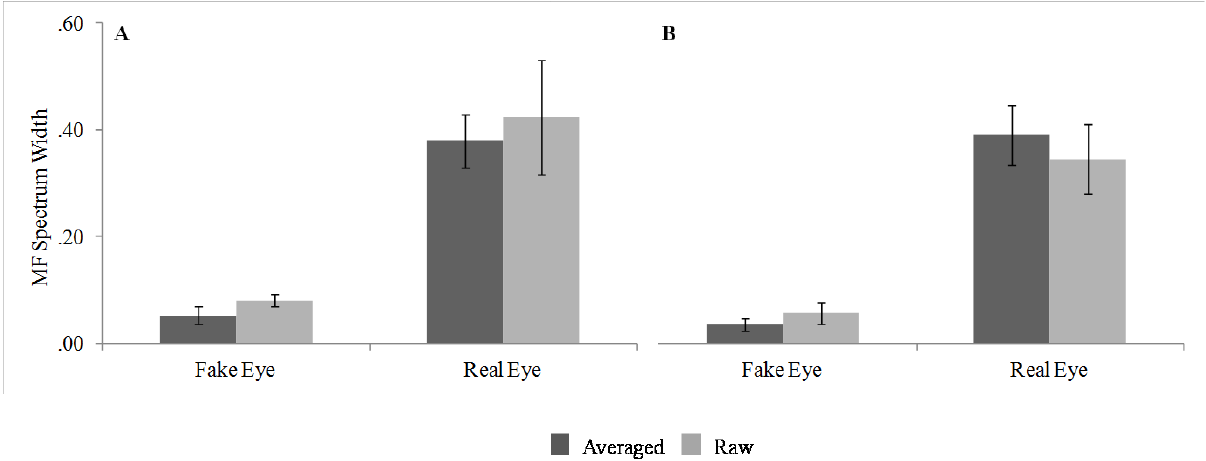
Figure 4. The effects of eye type and data-averaging in MFCWT analyses of (a) raw, untreated time-series and (b) shuf- fled